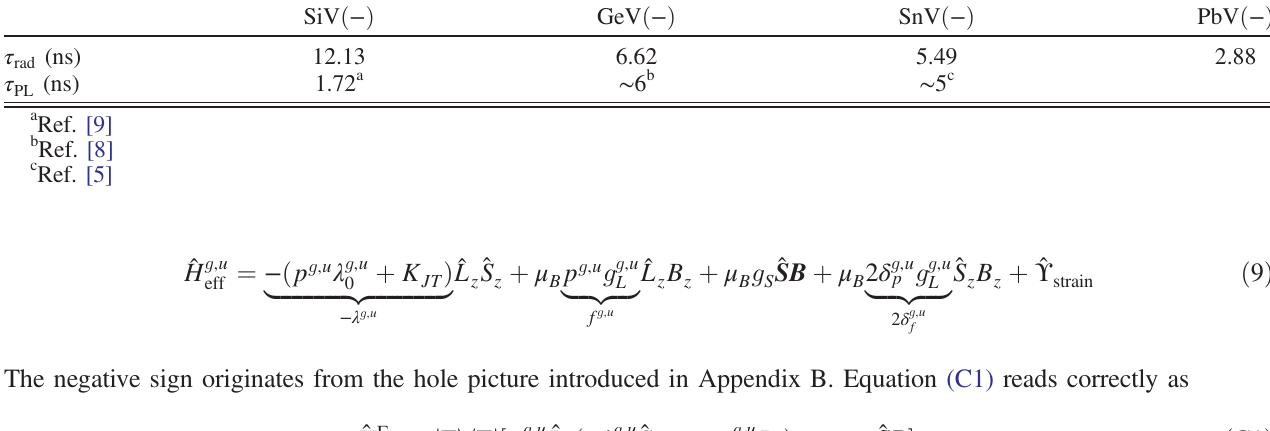
TABLE II. The calculated radiative lifetimes ( τ ) versus the observed photoluminescence lifetimes ( τ rad cryogenic temperatures. We use the experimental ZPL energy where available in the calculation of τ radiative and nonradiative processes. SiV ð − Þ GeV ð − Þ SnV ð − Þ PbV ð −